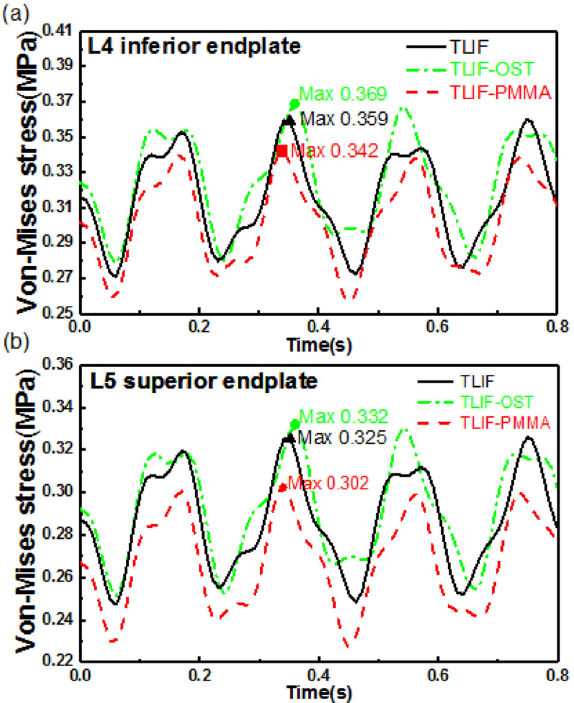
Fig. 5 Dynamic response of von Mises stress. a L4 inferior endplate and b L5 superior endplate for the fusion